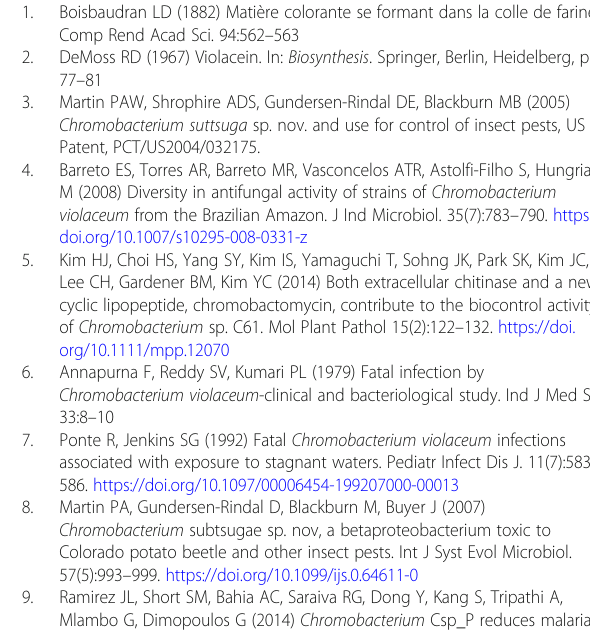
Additional file 2: Supplementary Table 1 Different Chromobacterium species with their niches